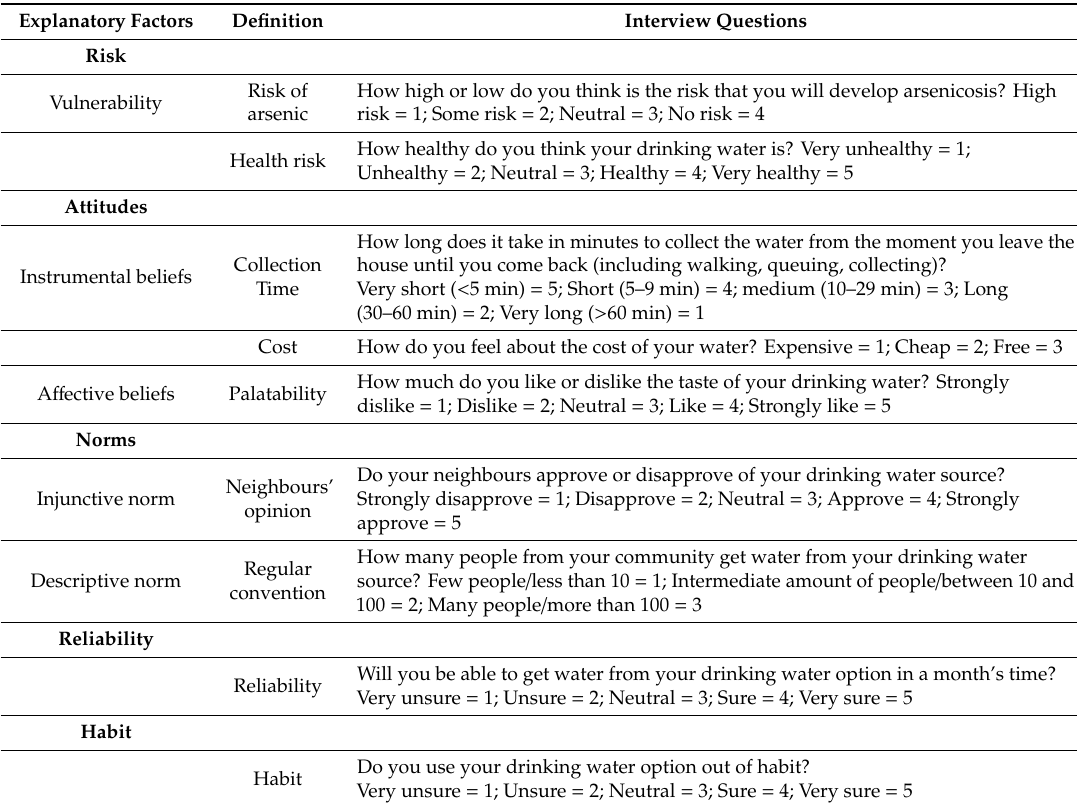
Table 1. Operationalisation of the variables explaining the variation in people’s attachment to their current drinking water